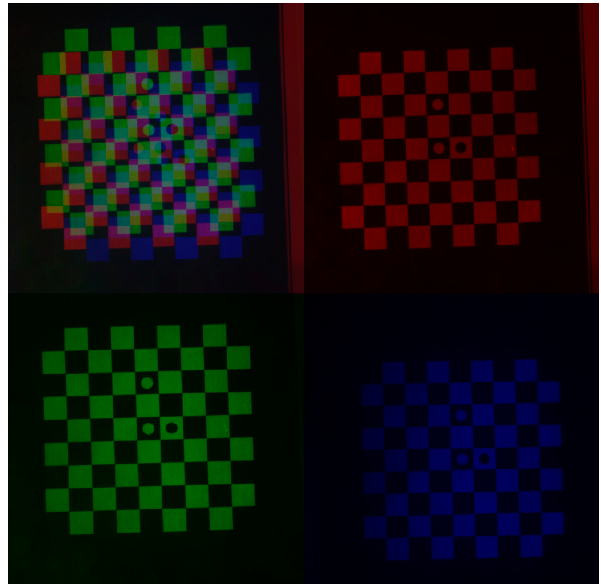
Figure 5. Calibration images (including the original and channel images).